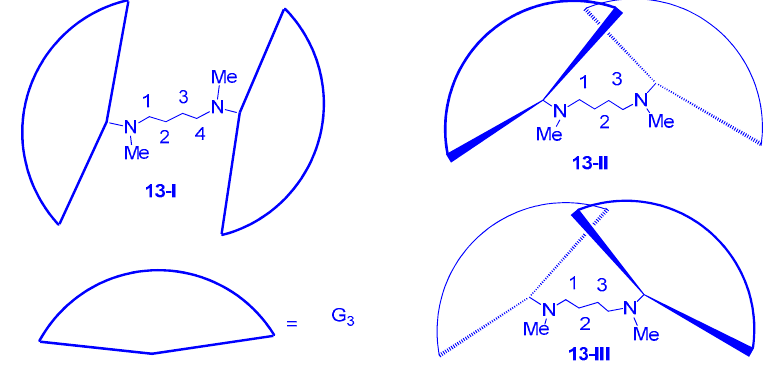
Figure 7. Isomers of dendrimers ( 13-I ), ( 13-II ), and ( 13-III ).